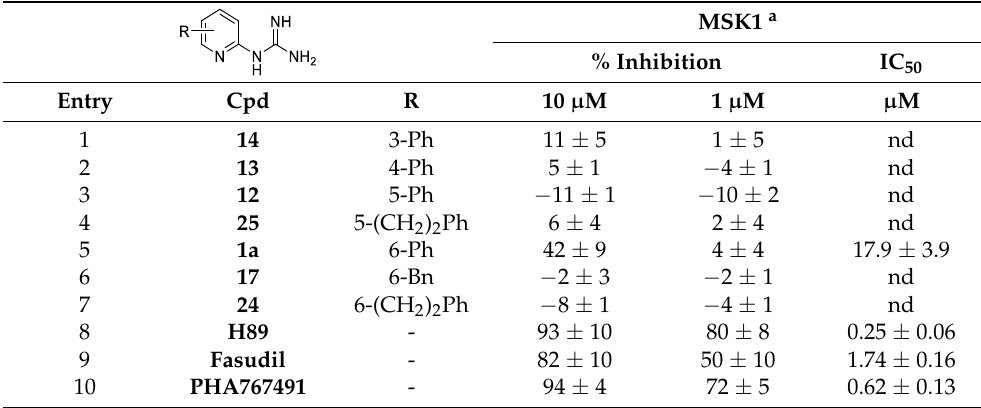
Table 1. Homologation and position of the phenyle on the pyridine scaffold.